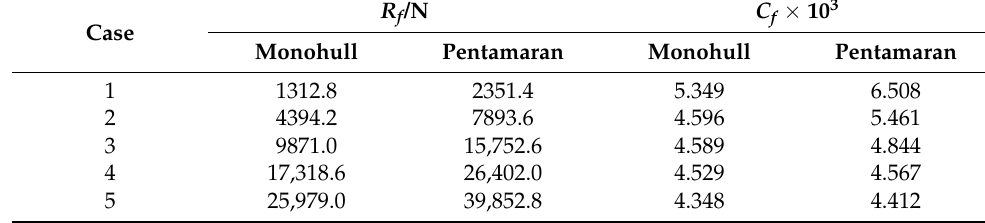
Table 11. Calculation results of pressure resistance.